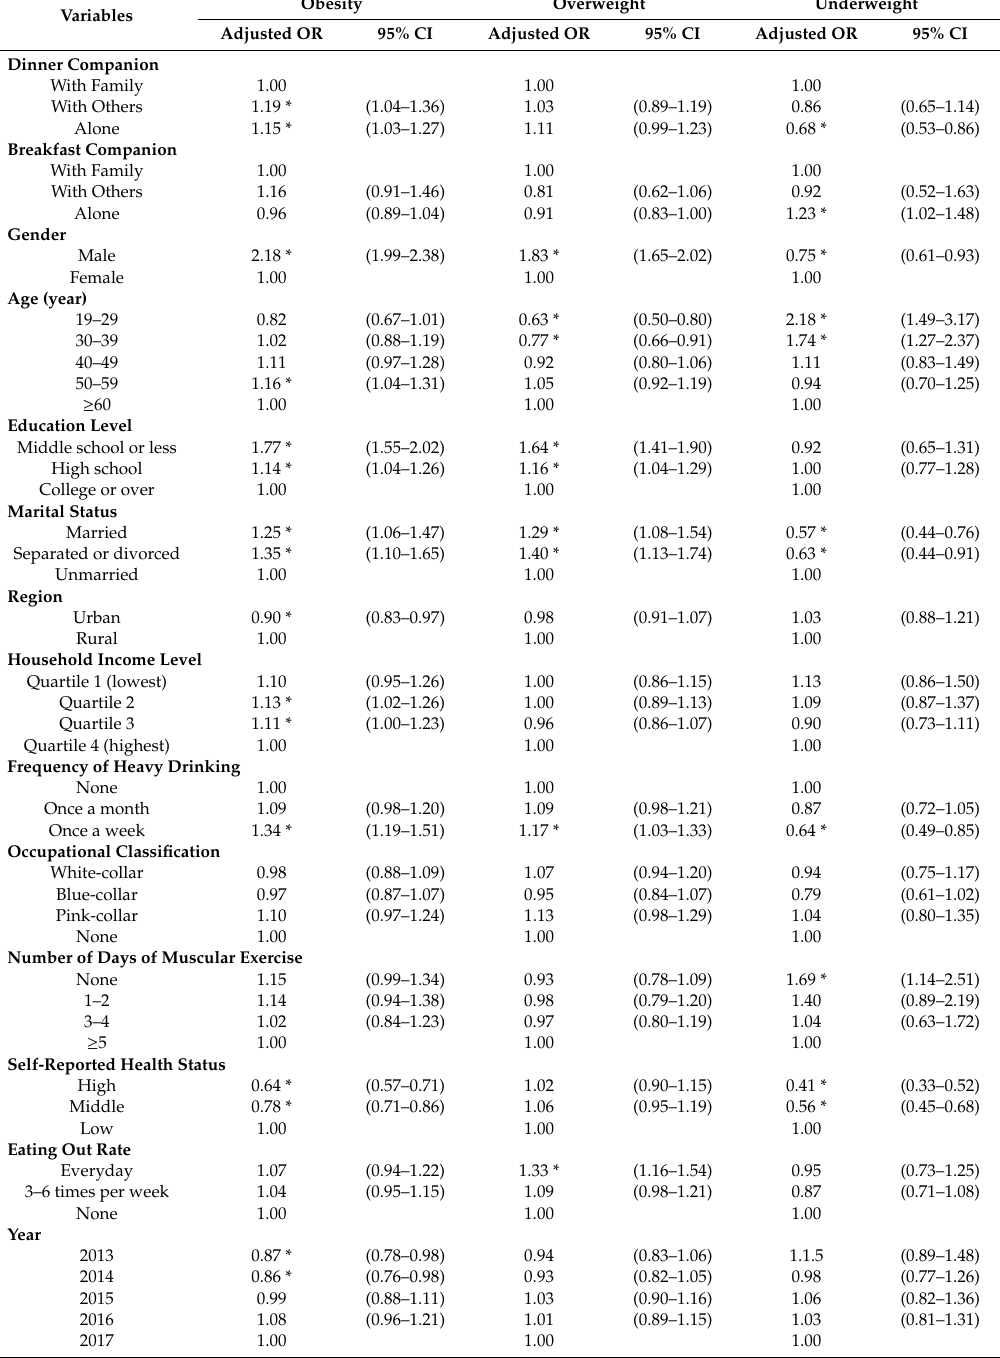
Table 2. Factors associated with body mass